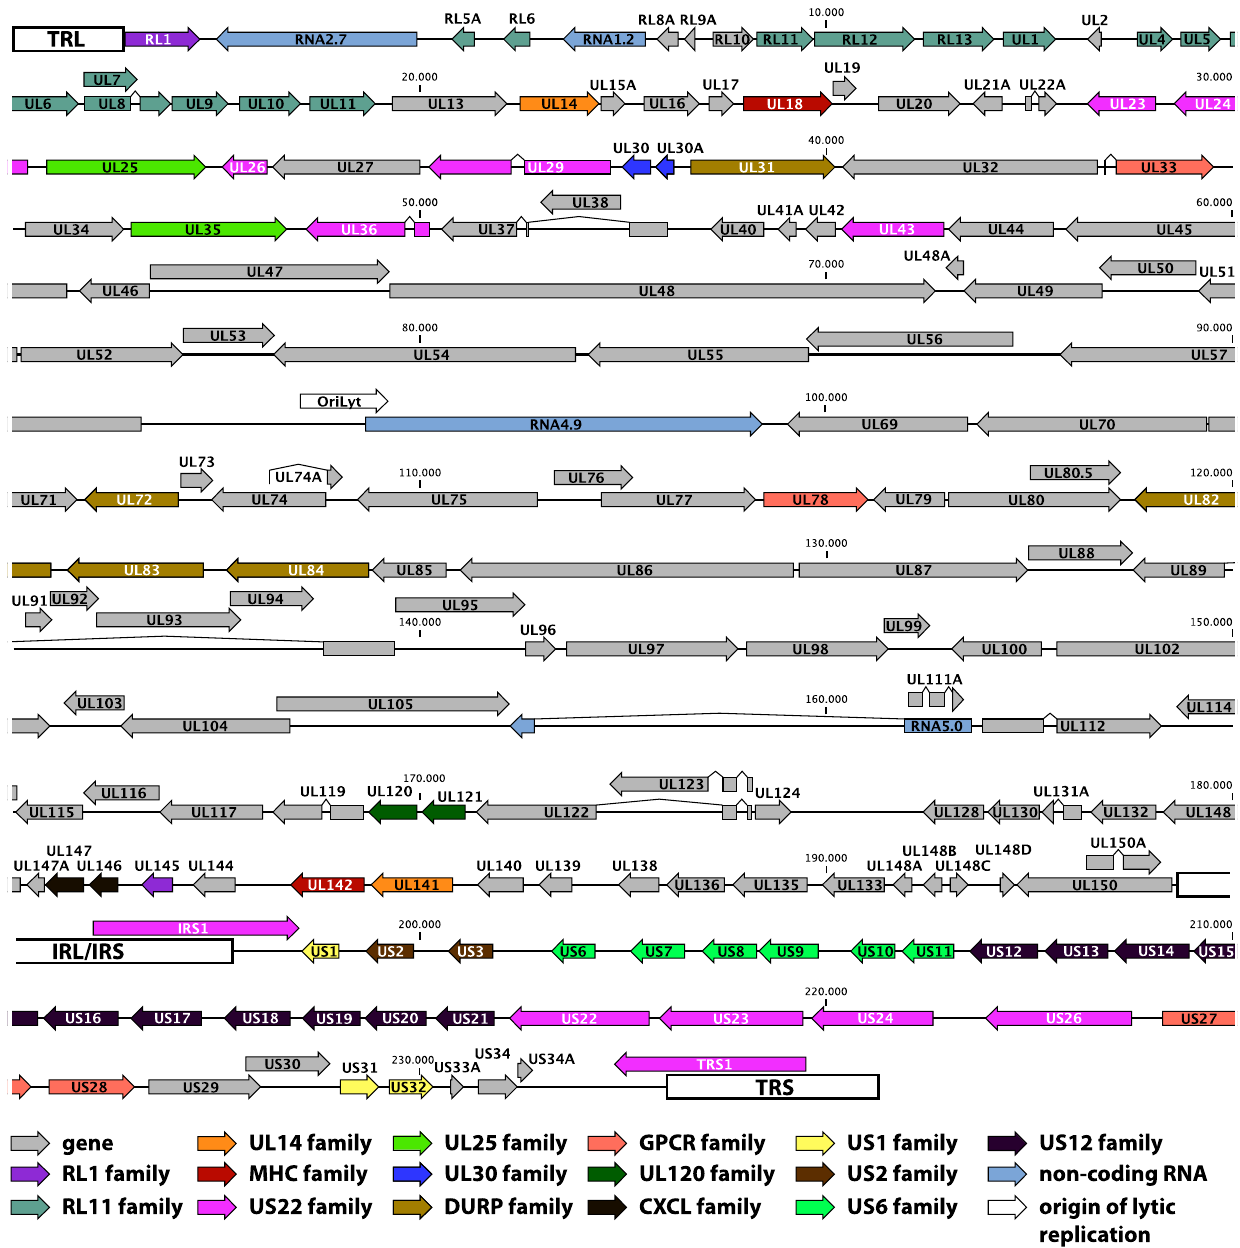
Figure 2. Genome annotation of the low-passage HCMV strain Merlin (GenBank accession NC_006273). The dsDNA genome is visualized as a single line; nucleotide positions are given in bps. Terminal and internal repeat regions (TRL, IRL/IRS and TRS) are indicated with white boxes. Arrows represent genes; different gene families are designated with different color codes, as illustrated below the genome. The four large non-coding RNAs and the origin of lytic replication are also